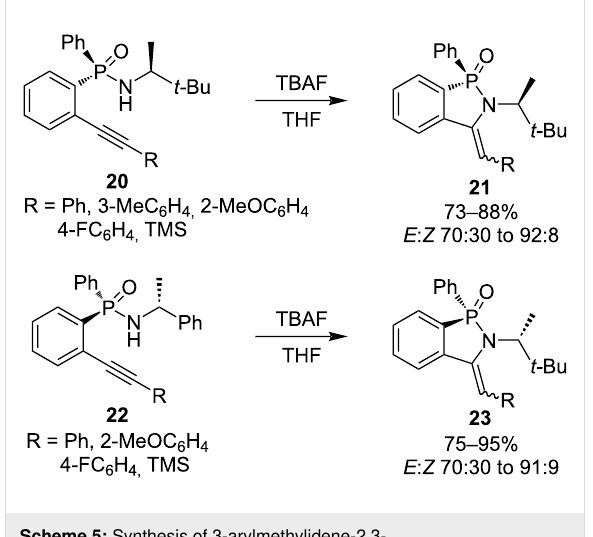
Scheme 5: Synthesis of 3-arylmethylidene-2,3- dihydrobenzo[ c ][1,2]azaphosphole 1-oxides via the